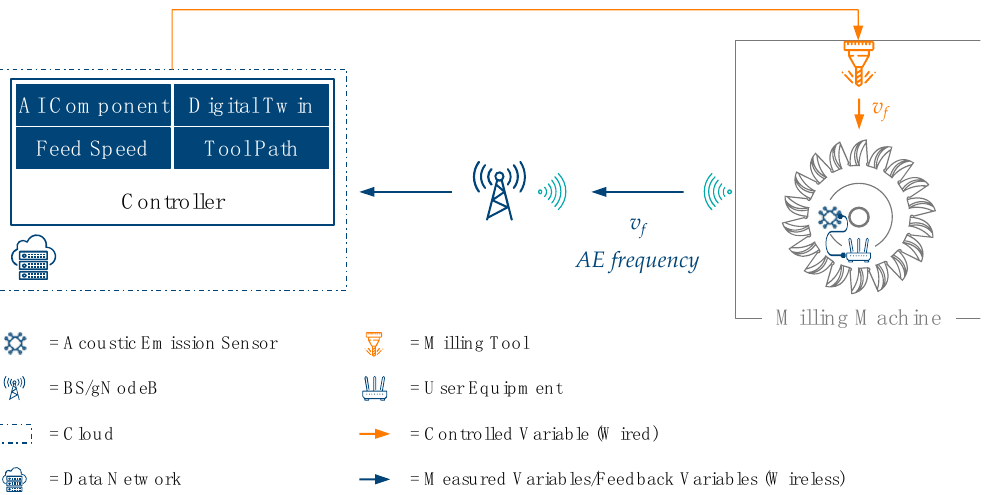
Figure 9. Simplified illustration of a milling machine producing BLISKs controlled via 5G-deployed NCS and corresponding control data flow.